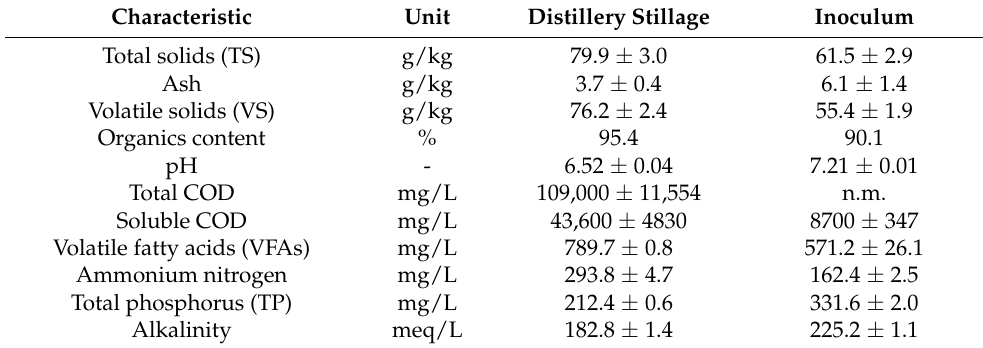
Table 1. Characteristics of distillery stillage and